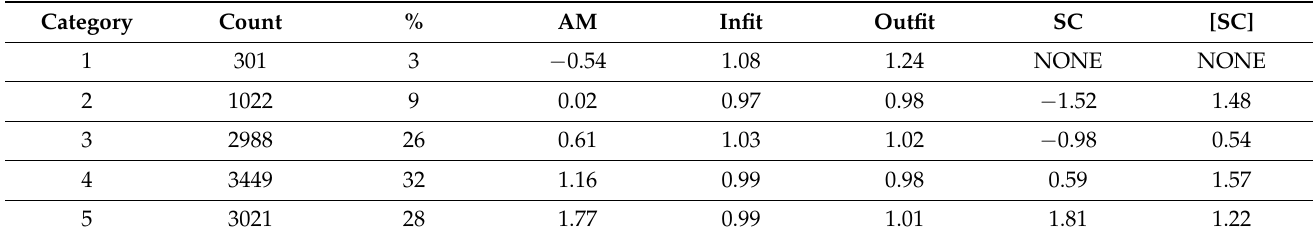
Table 7. Verification of the 5-point Likert Scale’s Appropriateness.